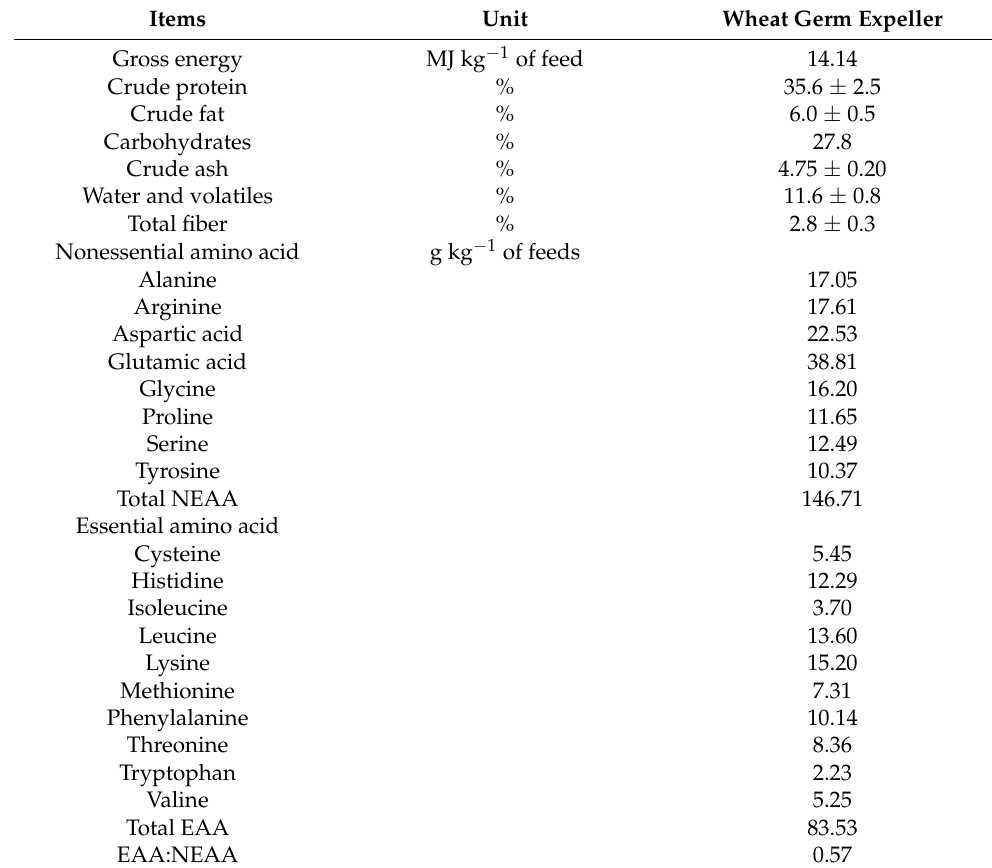
Table 2. Chemical composition of wheat germ expeller (Mean,